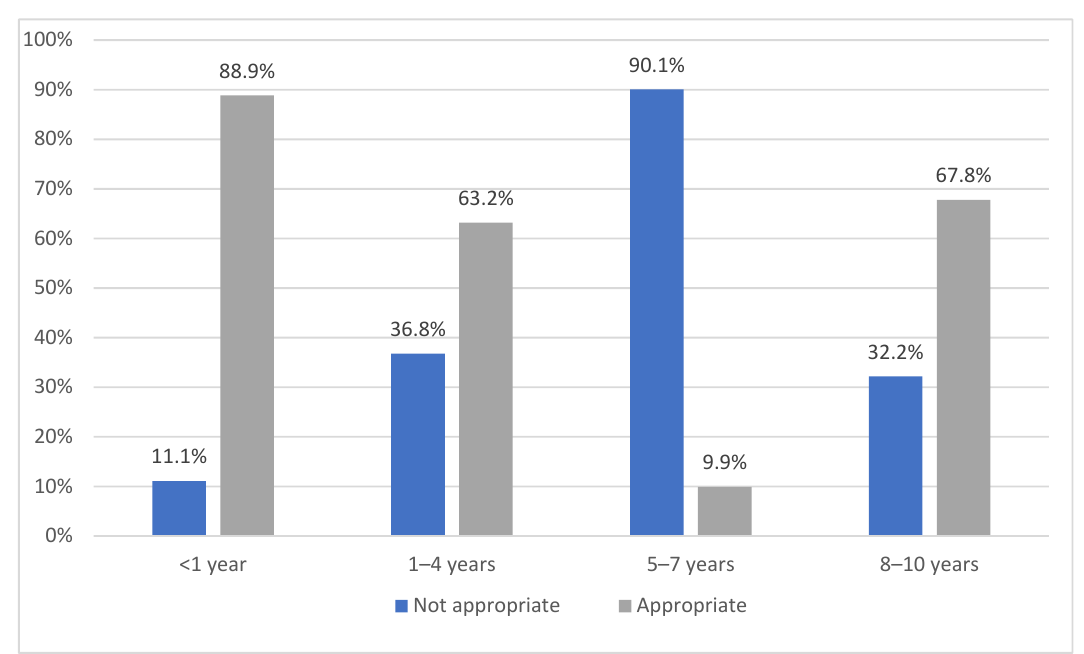
Figure 4. Appropriateness of restraint use by age group for the eldest child.